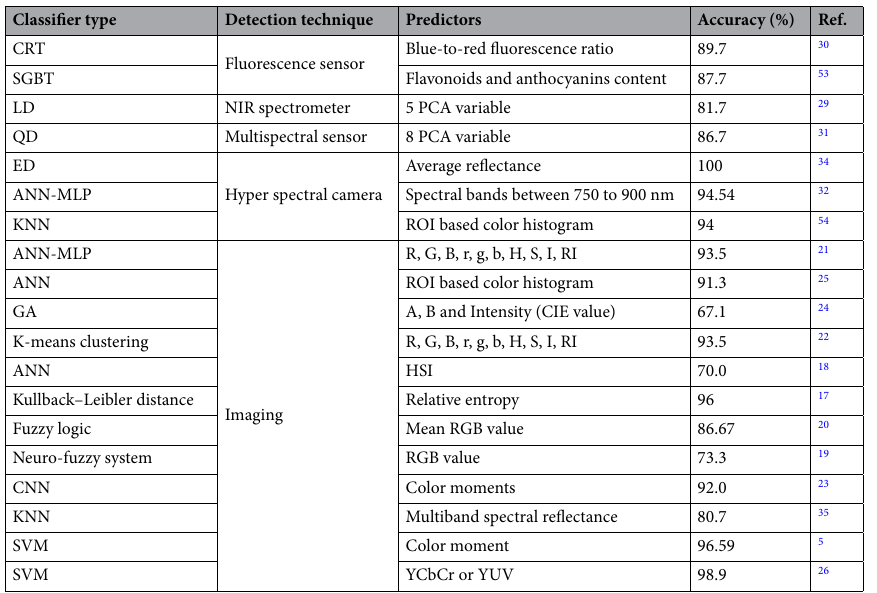
Table 3. Summary of classifiers reported in the